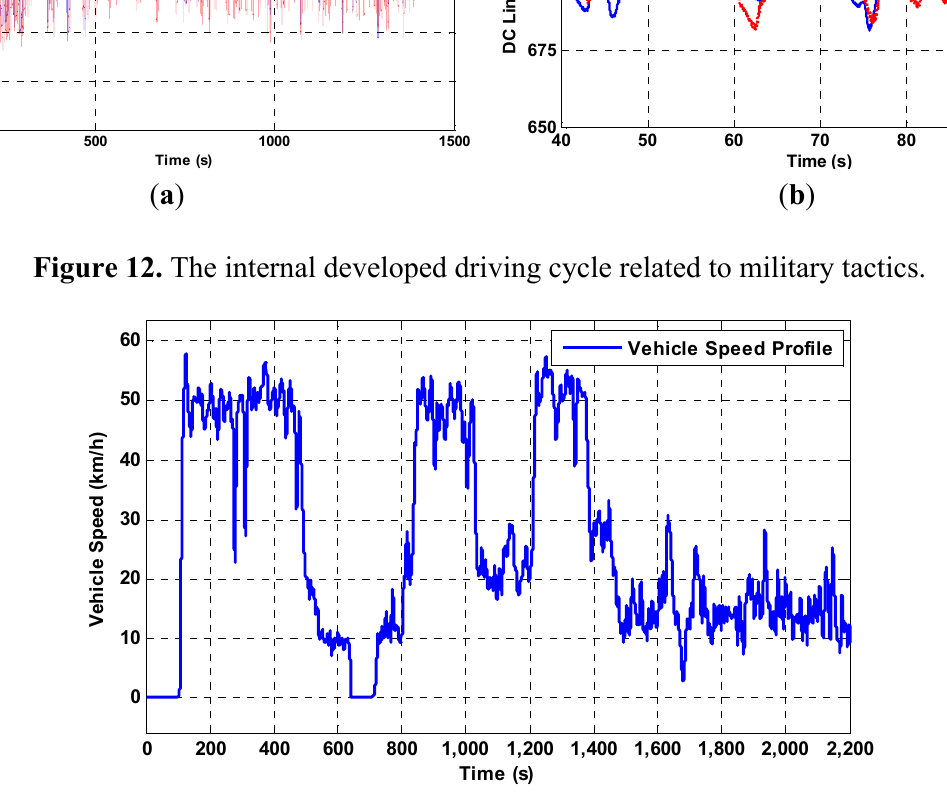
Figure 13. Battery characteristics evaluation result about the own driving